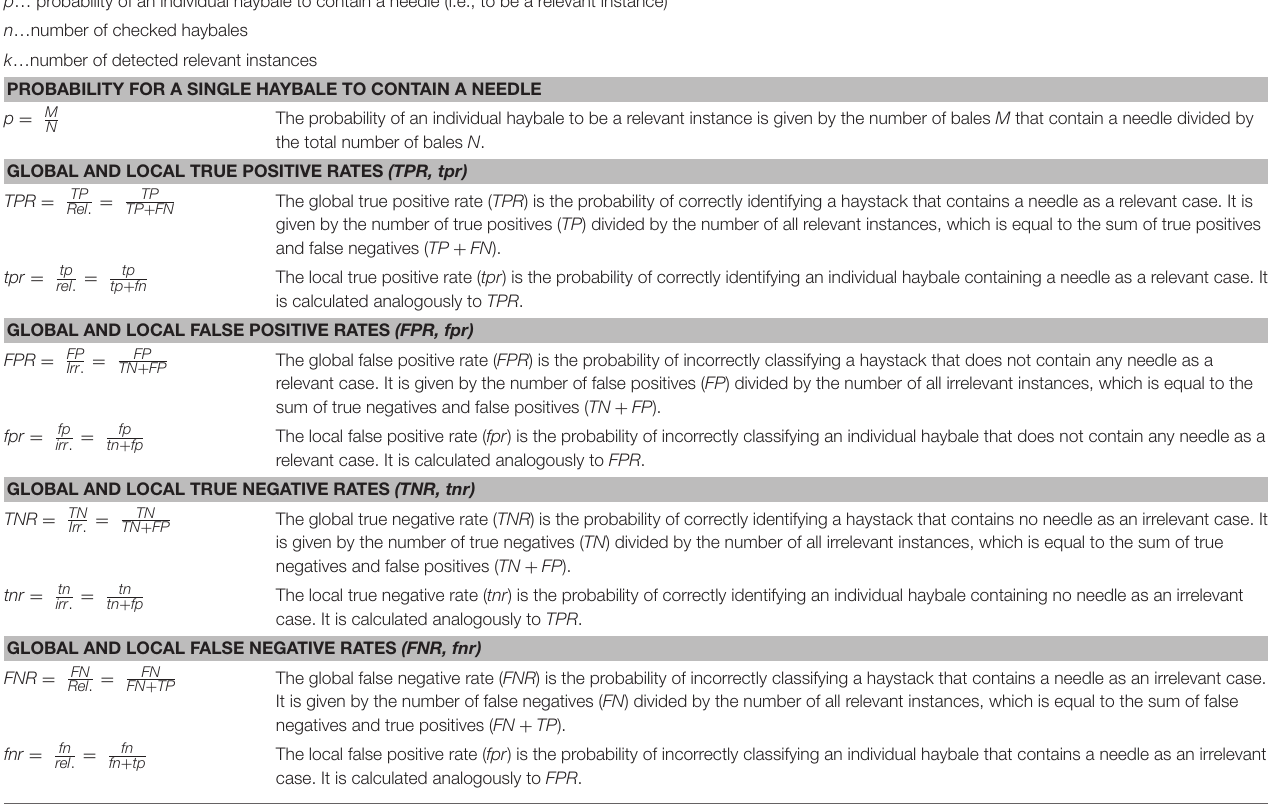
TABLE 1 | Statistical parameters. GENERAL